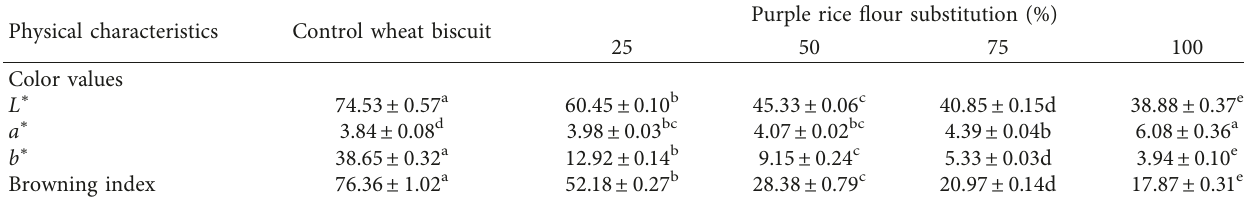
Table 4: L ∗ a ∗ b ∗ color values of the biscuits containing different levels of purple rice flours ∗ .